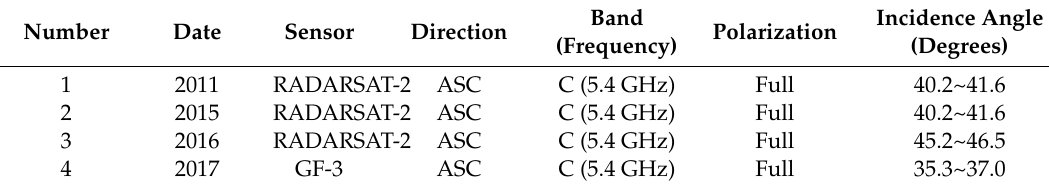
Table 3. Description of the second group of time-series images.